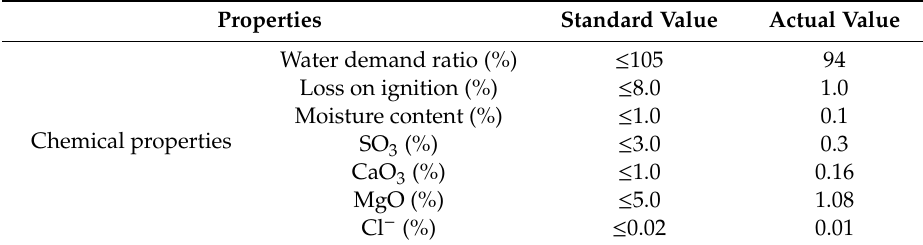
Table 3. Chemical properties of fly ash.